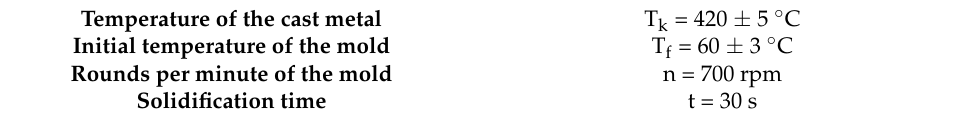
Table 3. Casting conditions.